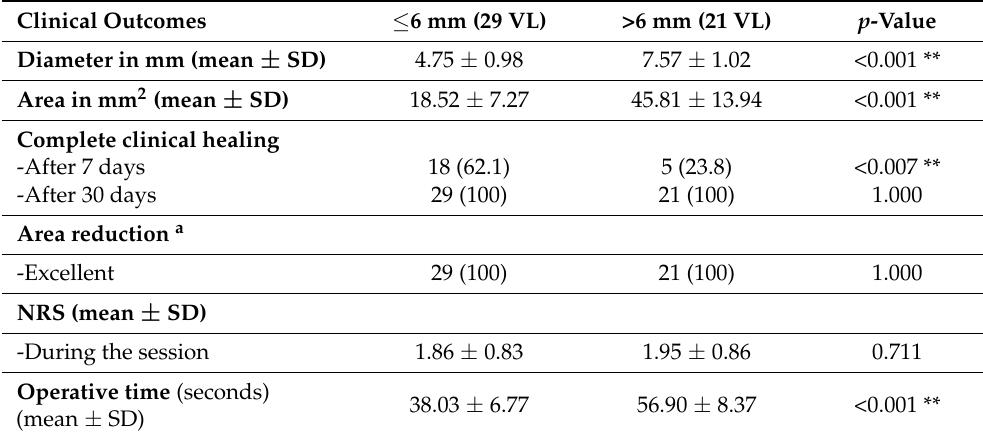
Table 4. Comparisons of clinical outcomes between VLs with a size of less than 6 mm and higher than 6